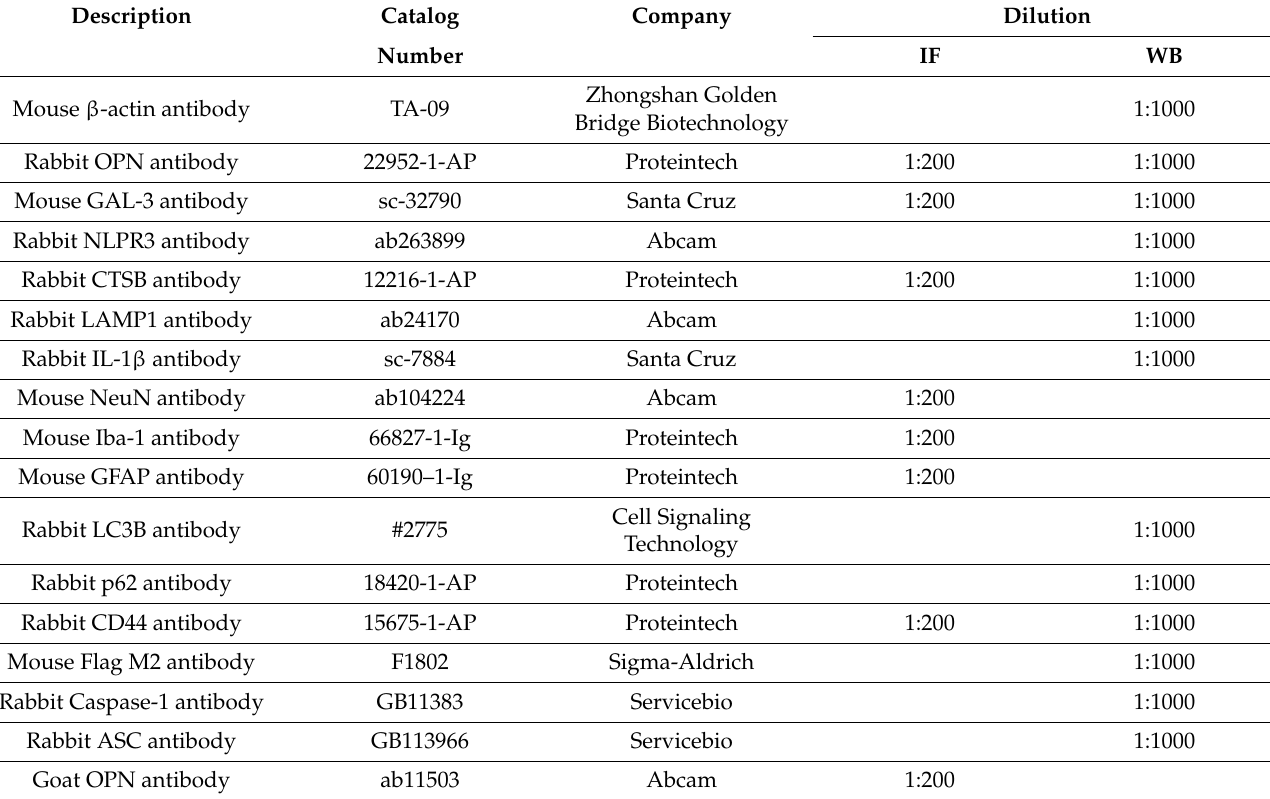
Table 1. Antibody